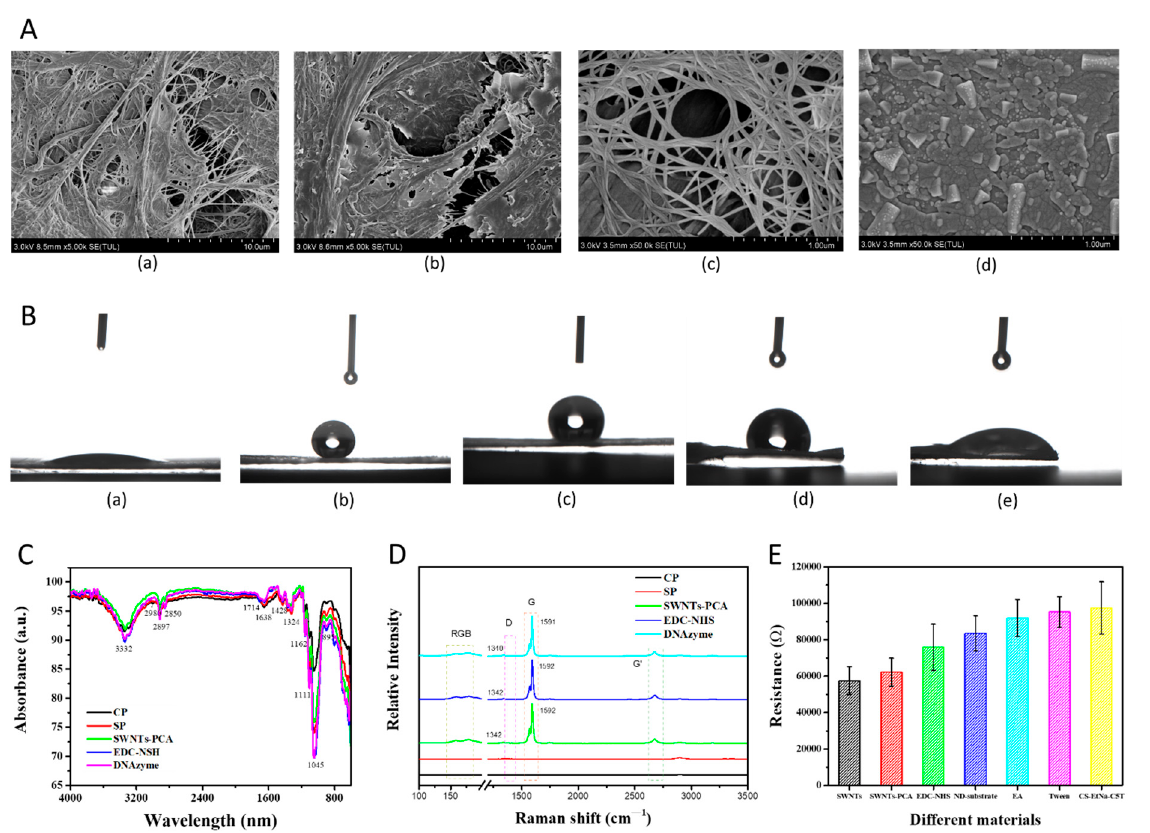
Figure 1. ( A ) SEM images of (a) CP, (b) SP,(c) SP/SWNTs-PCA, and (d) SP/silver paste; ( B ) WCA, ( C ) FTIR, and ( D ) Raman of CP functionalized with OTS, SWNTs-PCA, EDC-NHS, and DNAzyme; ( E ) resistances of SPFET modified with different materials (PCA, EDC-NHS, ND-substrate, EA, Tween 20, and CD-EtNa-C5T) at − 0.1 V; each data point was an average of measurements from 3 independent biosensors.